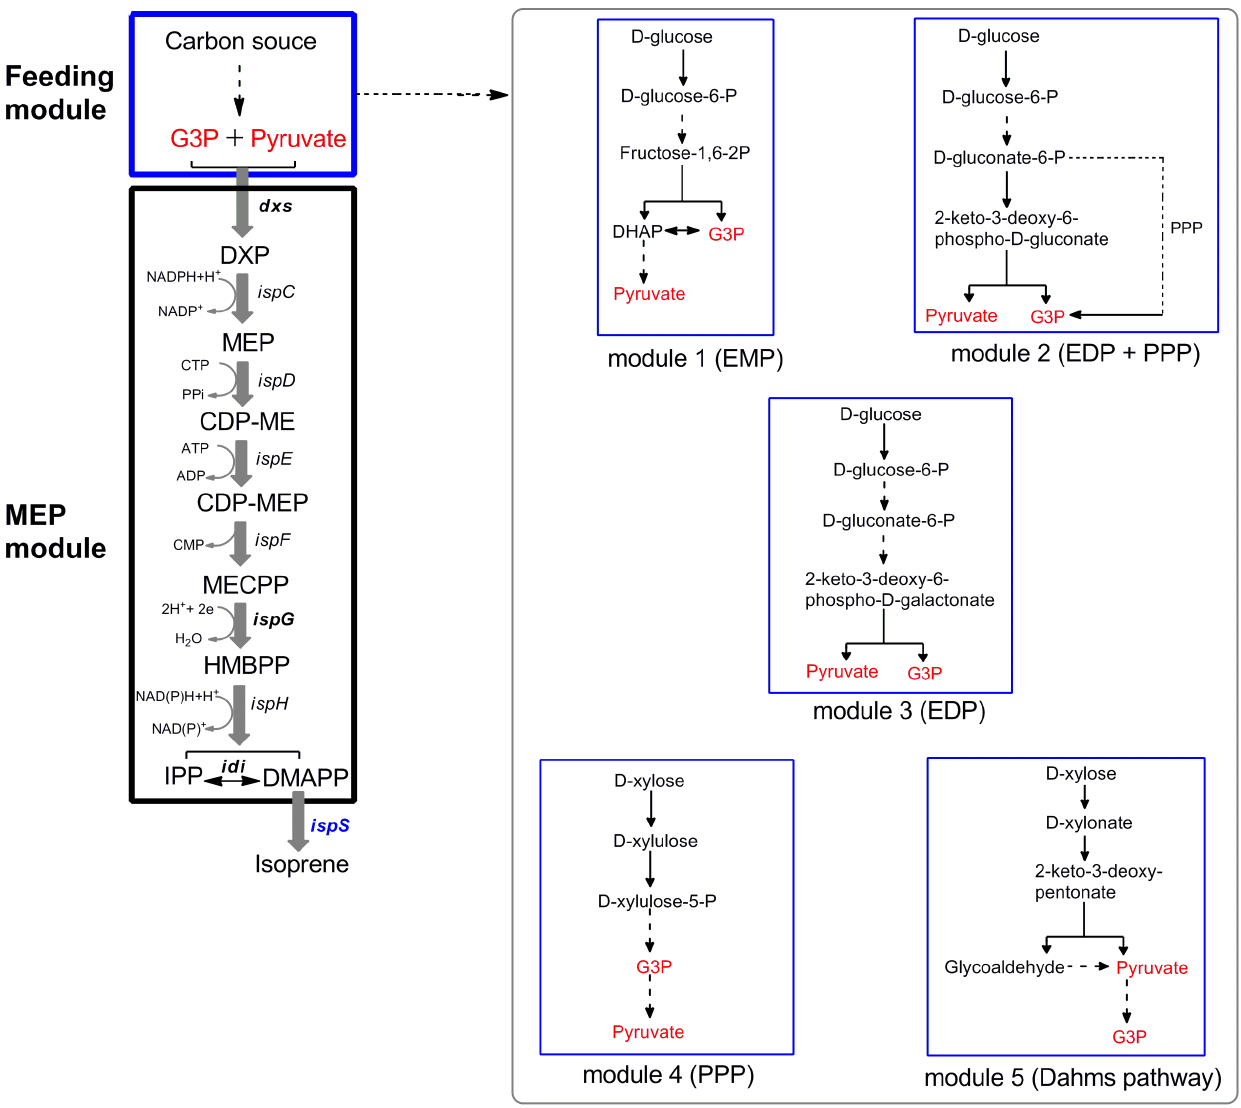
Figure 1. Participation of MEP-dependent isoprene biosynthesis pathway into two modules. Gene symbols and the enzymes they encode (all genes were from E. coli except where noted): dxs , DXP synthase; ispC , DXP reductionisomerase; ispD , DXP-ME synthase; ispE , CDP-ME kinase; ispF , MECPP synthase; ispG , HMBPP synthase; ispH , HMBPP reductase; idi , IPP isomerase; ispS , isoprene synthase ( P. alba ). Pathway intermediates: G3P, glyceraldehyde-3-phosphate; DXP, 1-deoxy-D-xylulose 5-phosphate; MEP, 2- C -methyl-D-erythritol 4-phosphate; CDP-ME, 4-diphosphocytidyl-2- C -methyl-D-erythritol; CDP-MEP, 4-diphosphocytidyl-2- C -methyl-D-erythritol 2-phosphate; MECPP, 2- C -methyl-D-erythritol 2,4- cyclopyrophosphate; HMBPP, 1-hydroxy-2-methyl-2-( E )-butenyl 4-pyrophosphate; IPP, isopentenyl pyrophosphate; DMAPP, dimethylallyl